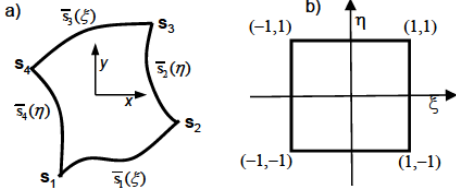
Figure 3: Domains: (a) physical domain; (b) computational